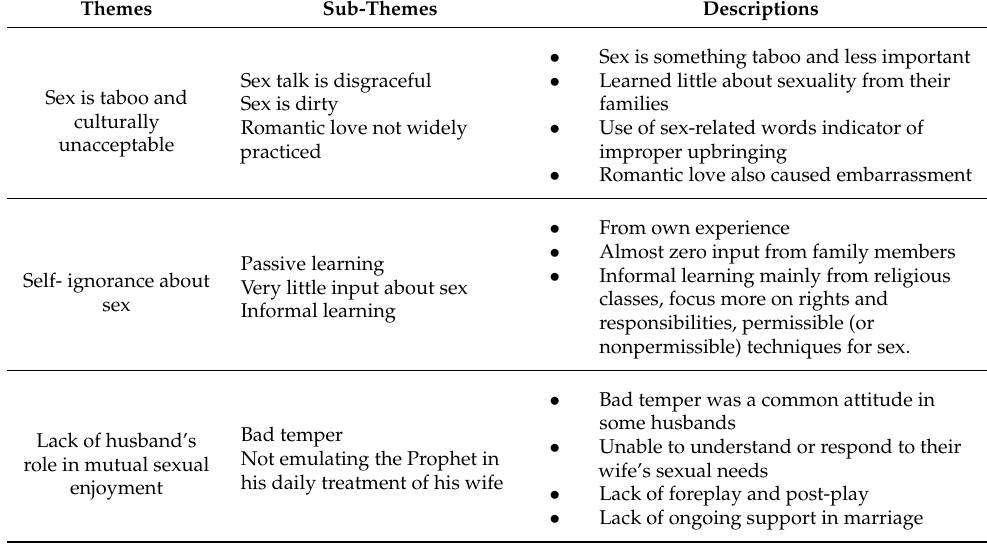
Table 2. Themes generated according to influence of culture and religion on the aetiology of female sexual dysfunction (FSD) ( n =